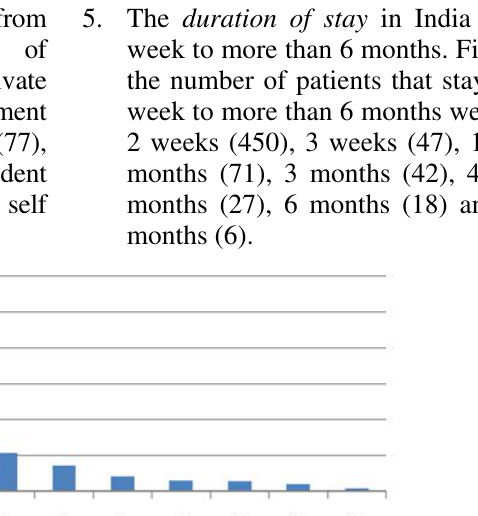
Fig. 1. Occupation of medical tourists from Bangladesh Source: developed for this research.